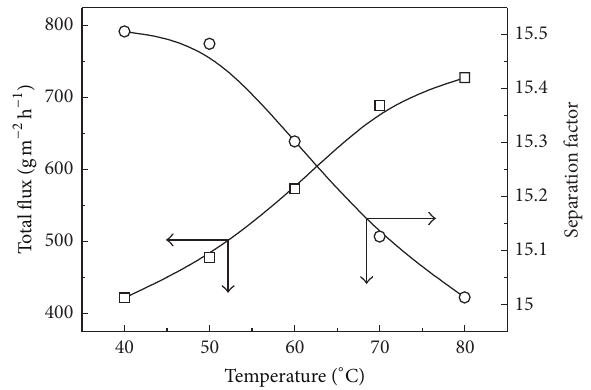
Figure 8: Feed temperature effect on PV performance of PDMS- VTOS membrane feed concentration, 6wt%, the weight ratio of H- PDMS:VTOS :DBTDL is 1:0.2 :0.02, the cross-linking tempera- ture is 80 ∘ C.